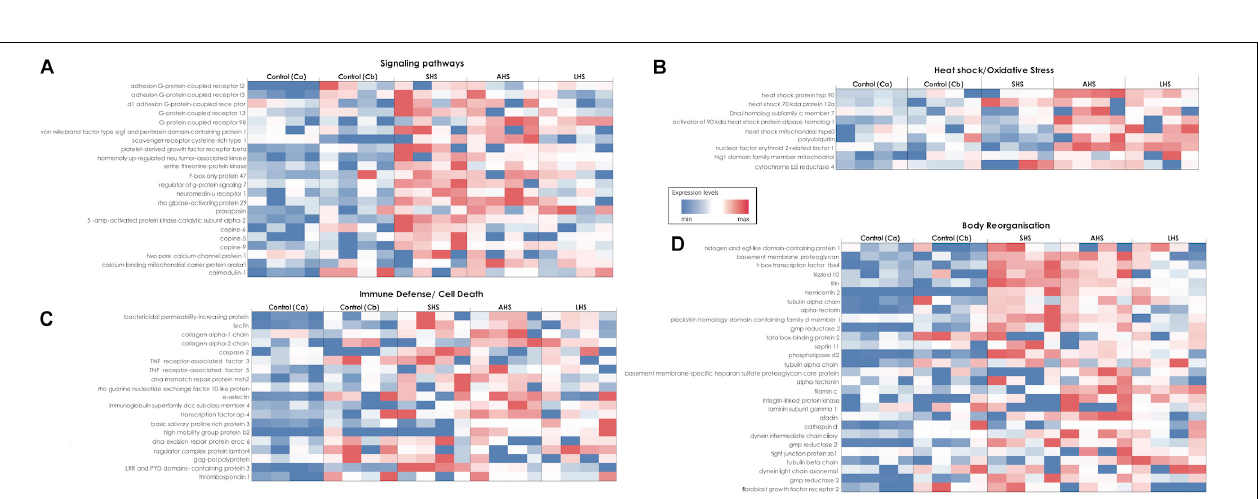
FIGURE 3 | Heatmaps showing the relative expression level of target genes in all the different conditions of the experiment. Expression levels increase from blue to red. The different heatmaps (A–D) represent different groups of genes according to their function. (A) Signaling pathways. (B) Heat shock and oxidative stress. (C) Immune response and Cell death. (D) Skeleton formation and body organization. SHS, Short heat Shock; AHS, Acute Heat Shock; LHS, Long Heat Shock; Ca, control treatment at the first sampling point; Cb, control treatment at the last sampling point.